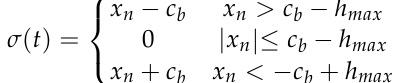
Figure 3. Schematic diagram of gear contact form.